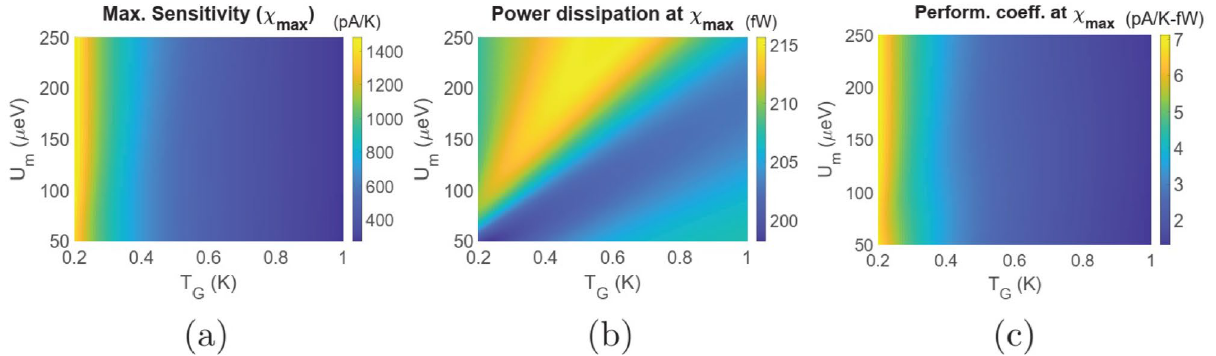
Figure 7. Maximum sensitivity and parameters at maximum sensitivity for the triple dot thermometer. Colour plot demonstrating the variation in ( a ) maximum sensitivity ( χ max ) ( b ) power dissipation at maximum sensitivity and ( c ) performance coefficient at maximum sensitivity with variation in the Coulomb coupling energy ( U m ) and target reservoir temperature ( T G ). The parameters used for simulation are T L ( R ) = 300 mK, γ l (ξ) = γ r (ξ) = γ g (ξ) = γ(ξ) = γ c = 10 µ eV and V = 1.1